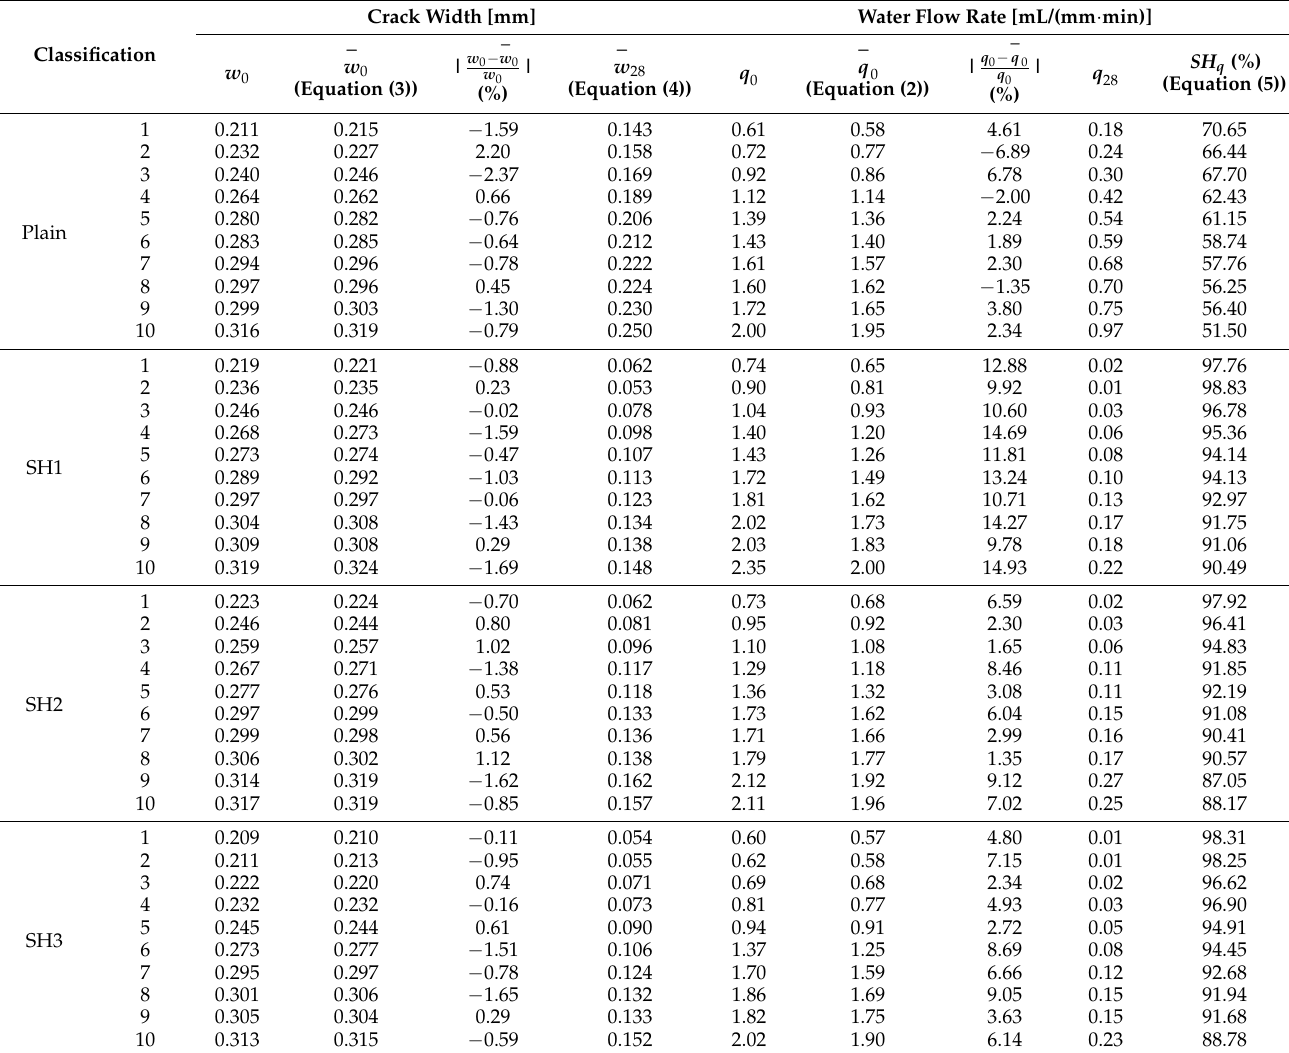
Table 3. Water permeability test results for selected crack